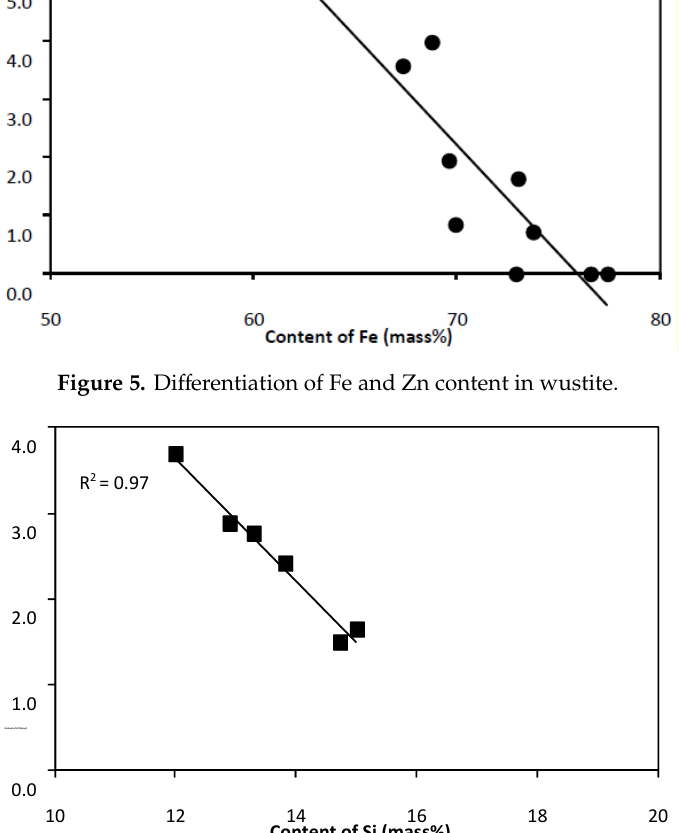
Figure 7. Differentiation of Fe and Cu content in kirschsteinite. Figure 8. Differentiation of Fe and Ca content in kirschsteinite. R 2 = 0.85 12 13 14 15 16 17 18 19 20 10